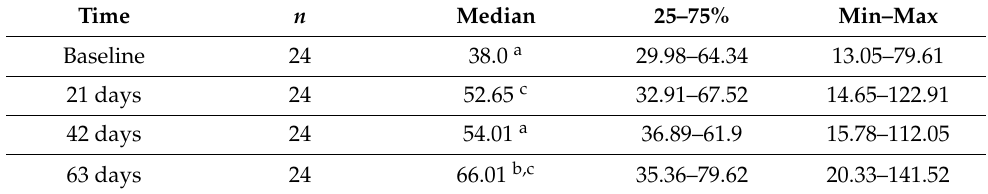
Table 2. Leopard gecko testicular volume (mm 3 ) measured by ultrasound over time.